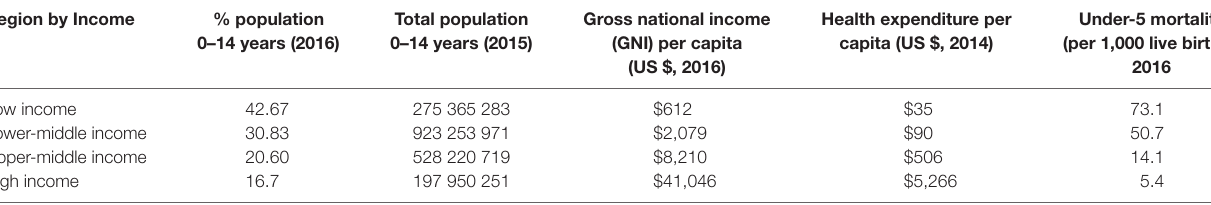
TAbLe 1 | Data on population, mortality, and health expenditure by income region (8). Region by